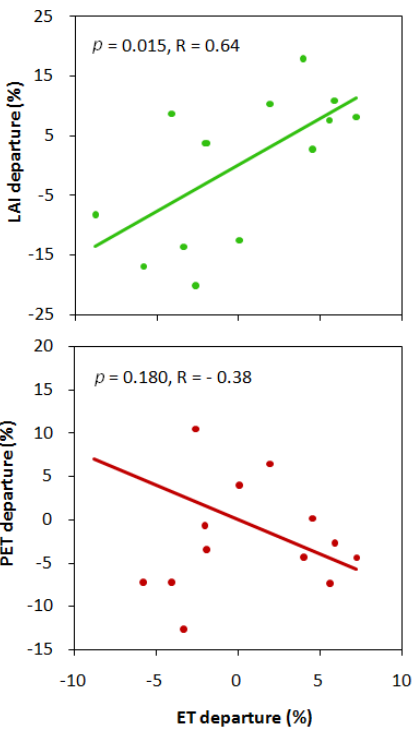
Figure 7. Correlations of the departures of basin-level ET with (a) the departures of mean leaf area index (LAI) and (b) the depar- tures of PET in the peak growing season (July–August) over 2000– 2013 in the Qinhuai River basin.